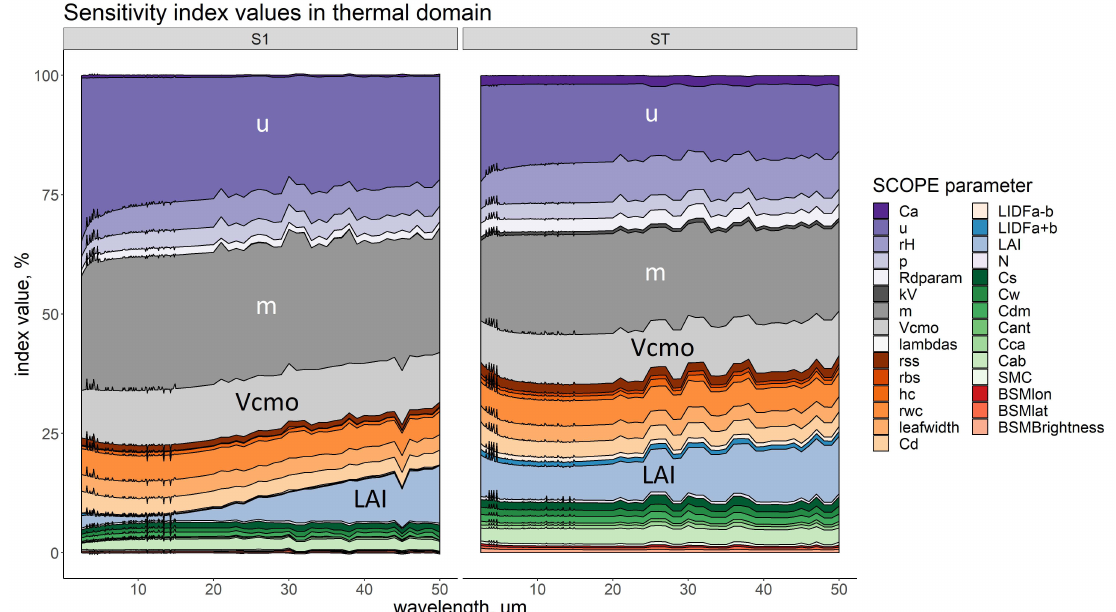
Figure 8. First (S1) and total (ST) order sensitivity indices for top of canopy outgoing thermal radiance in observation direction simulated with complete SCOPE model presented as percentages. Definitions of parameters can be found in Table